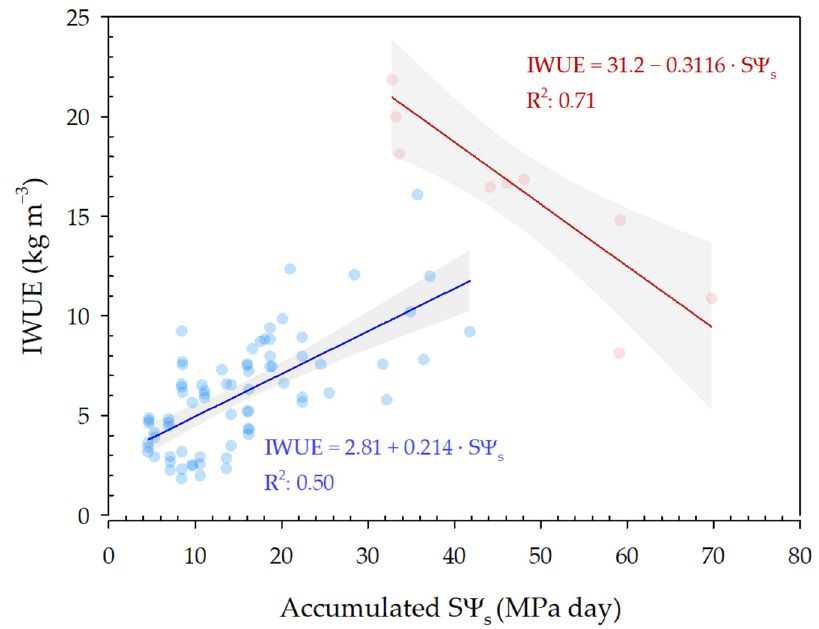
Figure 2. Relationship between the cumulative water stress integral (S Ψ s ) and the irrigation water use efficiency (IWUE) obtained in ‘Crimson Seedless’ vines under different irrigation regimes. Blue circles correspond to vines without water restriction or subjected to RDI or PRD during post- veraison, without negatively affecting productive parameters. Red circles correspond to vines that were subjected to deficit irrigation during the critical periods and whose yield or berry quality was negatively affected in the short or long term (NI and SDI). n = 67, each point corresponds to a rep- licate of the irrigation treatments applied between 2011 and 2017. Lines correspond to the regres- sion model and the grey area to the 95% confidence interval for each group of data. 3.2. Water Stress Intensity and Productive Variables’ Effects on Berry Quality Figure 3 shows the relationship found between water stress and yield, firmness, and berry color. The values have been expressed as normalized variables, with a value of 1 corresponding to the maximum potential of each. As water stress increased, yield and berry firmness decreased, with yield being approximately 10% more sensitive than firmness. However, berry color increased due to water stress, stabilizing the values from 30 MPa day onwards. Therefore, an optimal range of S Ψ s , between 22 and 30 MPa day could be considered, since it allows the maximum productive potential (0.92) to be ap- proached, without significantly affecting berry firmness (0.94) and increasing berry col- oring (0.95) (Figure 3).